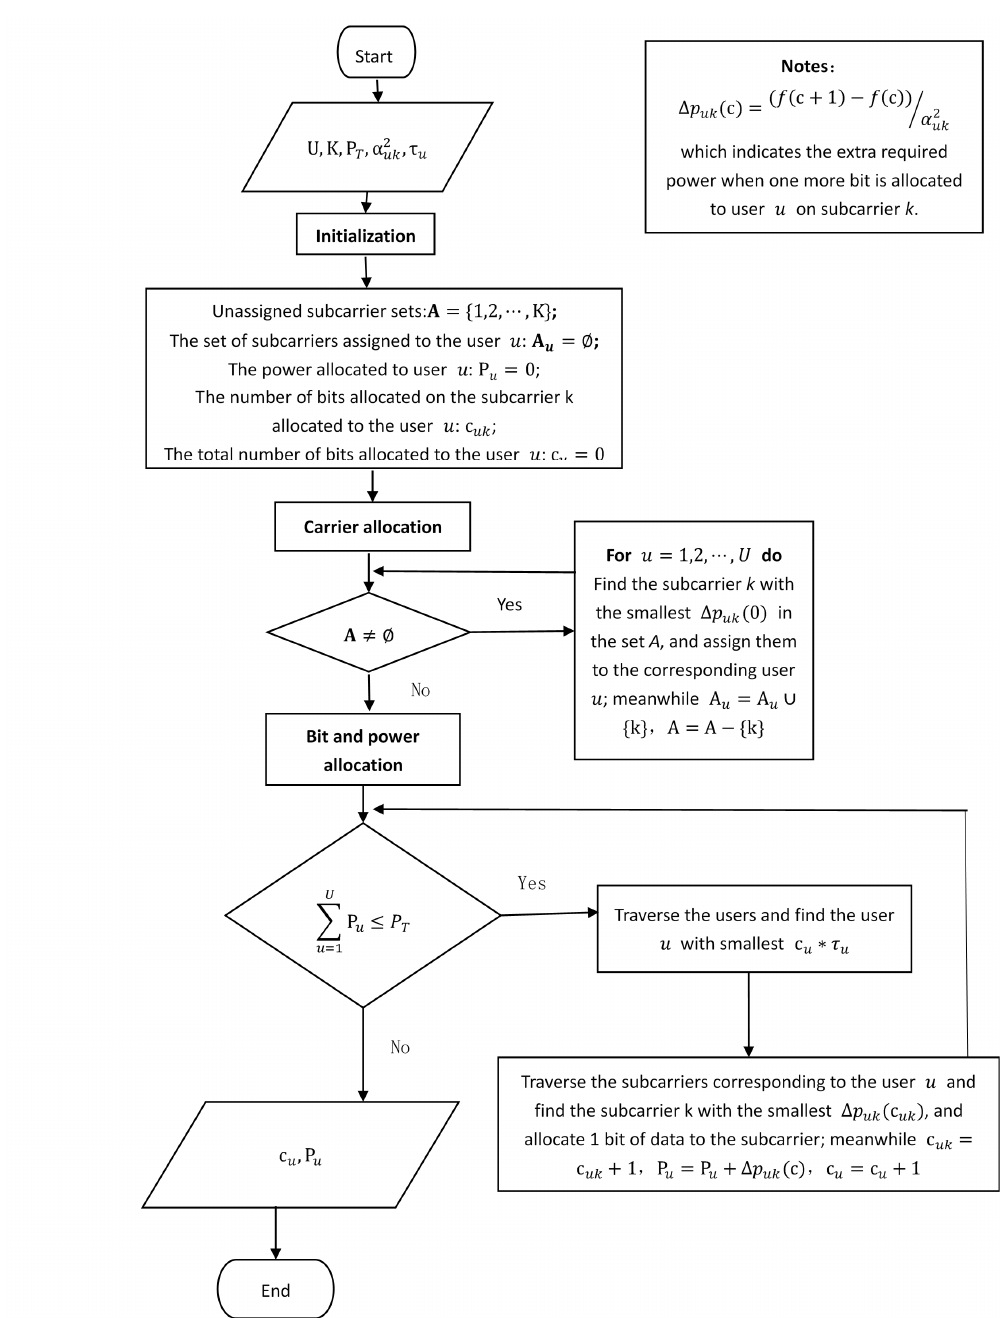
Figure 4. Proposed heuristic algorithm for capacity allocation with multiple